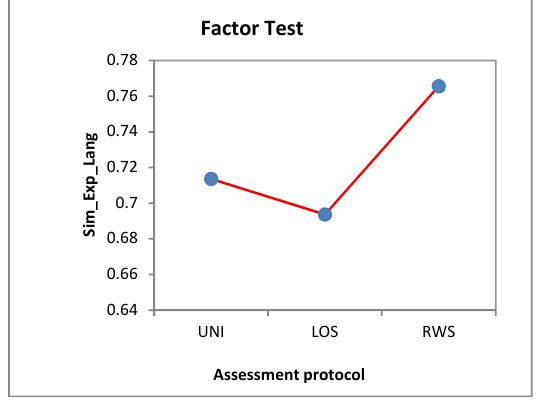
Figure 15. Relationship between SIM_Exp_Lang and the Assessment protocol variable.